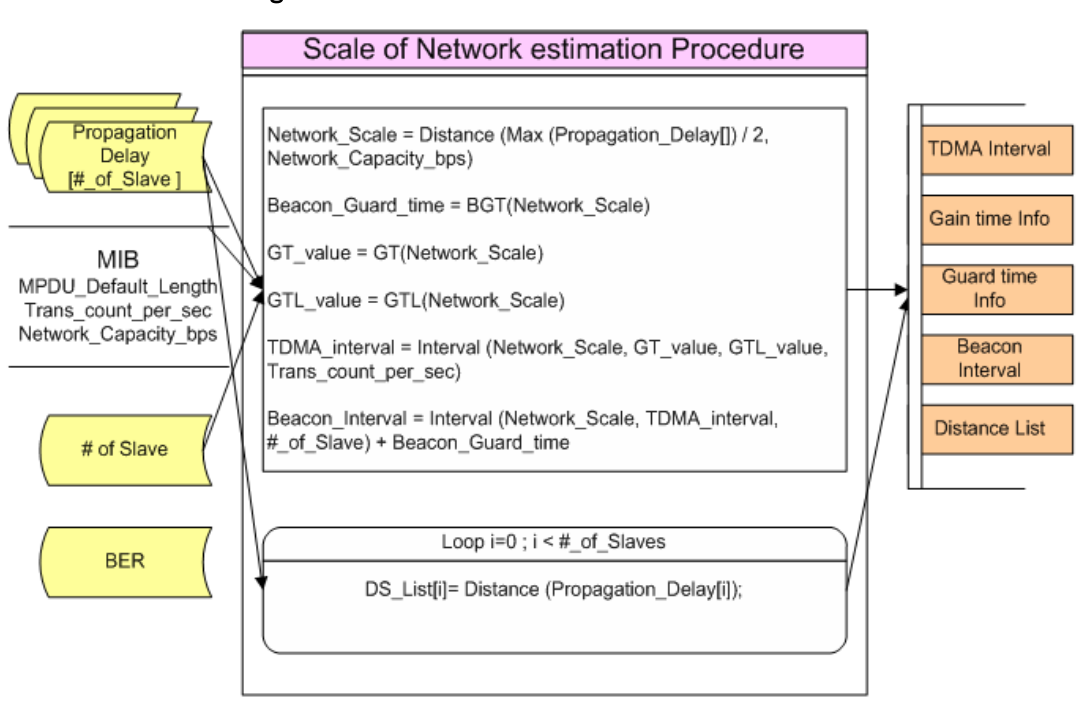
Figure 7. Scale of Network estimation